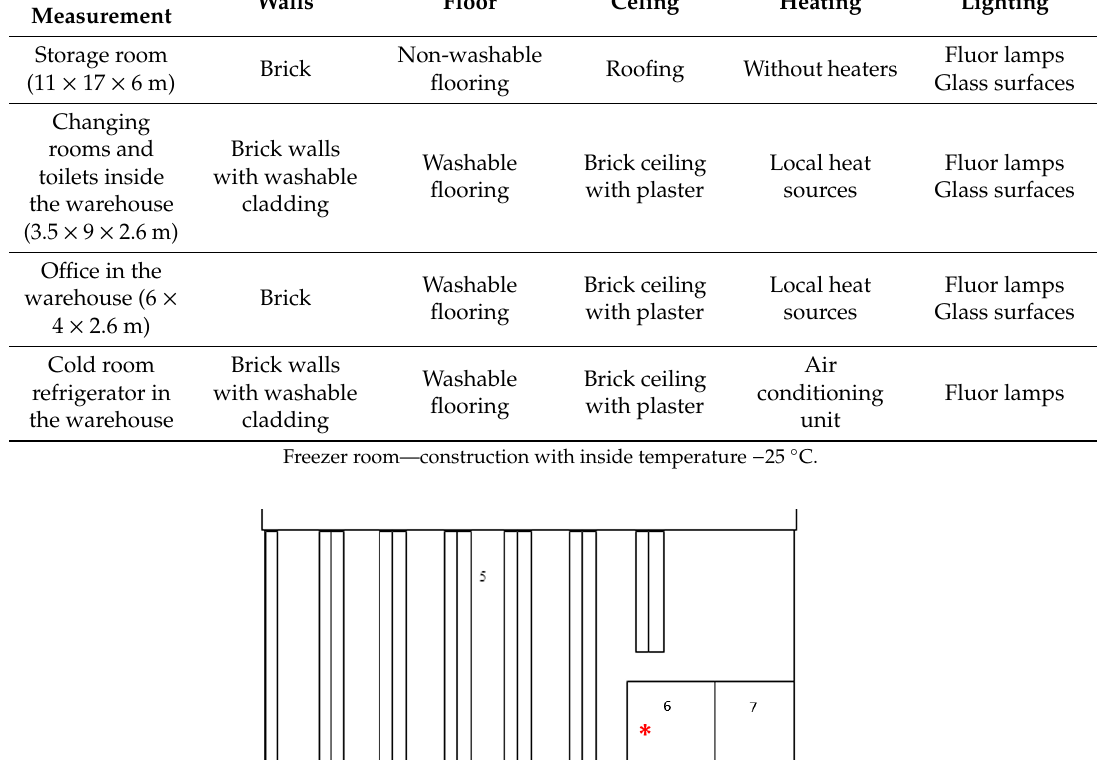
Table 1. Characteristics of the premises — overview.